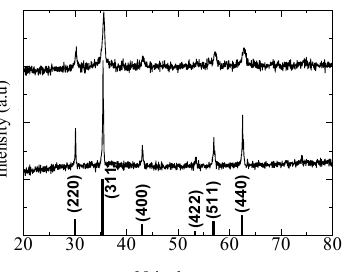
Figure 1. XRD pattern for synthetic nano Fe No.